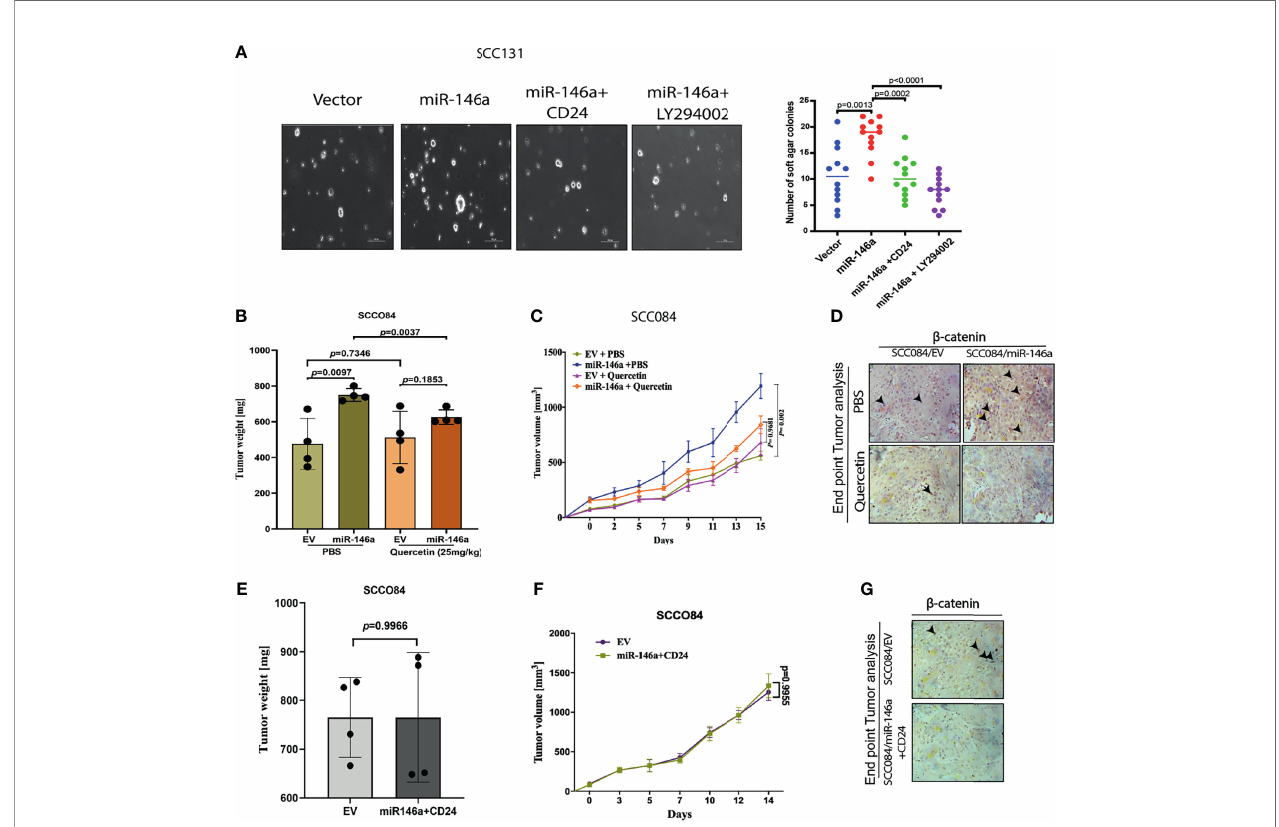
FIGURE 7 | MiR-146a promotes in vivo tumor growth which is rescued upon CD24/AKT modulation (A) Representative pictures of the colonies from the soft agar assay performed under given transfections and treatment conditions as shown (Left) (Scale bar=100 µm). Number of similar sized colonies were counted for each fi eld and avg ± sd were plotted and graphically represented. p- values are measured by mann-whitney u- test between 2 independent experiments (* P < 0.05). (B) Bar graphs showing relative weight (mg) of the xenograft tumors generated from control or miR-146a expressing SCC084 treated without or with Quercetin. Data represent mean ± SD (n = 4). P-values were computed using unpaired t-test. (C) Line graph showing relative growth rate of tumors in response to Quercetin in SCC084 cells harboring either control vector or stably expressing miR-146a. Once tumors reached a palpable size, one set of mice were injected with Quercetin (10 mg/kg) intraperitoneally and after 10 successive treatment, change in tumor volume was measured at regular interval up to 20 days. Data represent mean ± SD (n = 4) and p -values shown using 2-way ANOVA in GraphPad prism 8. (D) Immunohistochemistry showing nuclear b -catenin levels in the xenograft tumors obtained from the experiment described in b) (scale bar = 20 m M). (E) Bar graphs showing relative weight (mg) of the tumors described in xenograft tumors generated from SCC084 harboring either control vector or stably expressing miR146a and CD24. Data represent mean ± SD (n = 4). P-values were assessed using unpaired t-test (F) Line graph showing relative growth rate of tumors described in (E) . Data represent mean ± SD (n = 4). For all the time-course experiments, p -values were calculated using ANOVA in graph-pad prism8. (G) Immunohistochemistry showing nuclear b -catenin levels in the xenograft tumor obtained from the experiment described in (E) (scale bar = 20 m